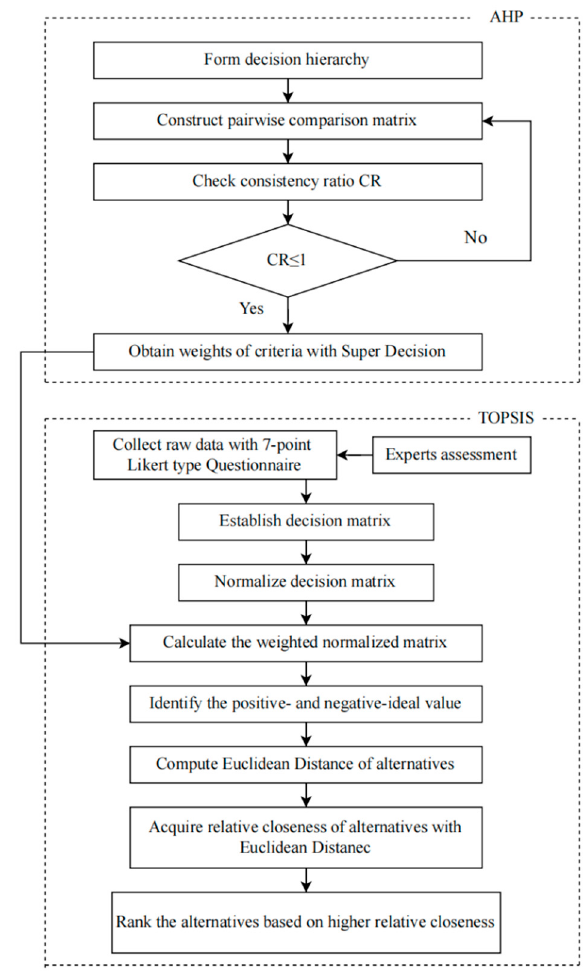
Figure 2. Framework of AHP–TOPSIS.